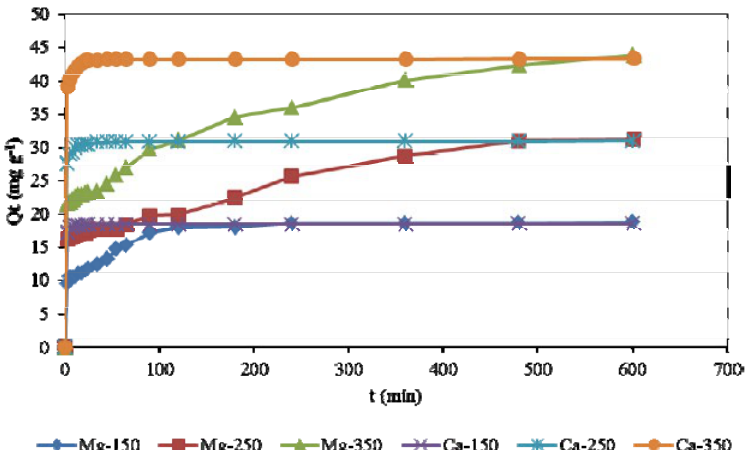
Fig. 12. The Ca 2+ and Mg 2+ competitive exchange data with different initial concentration.